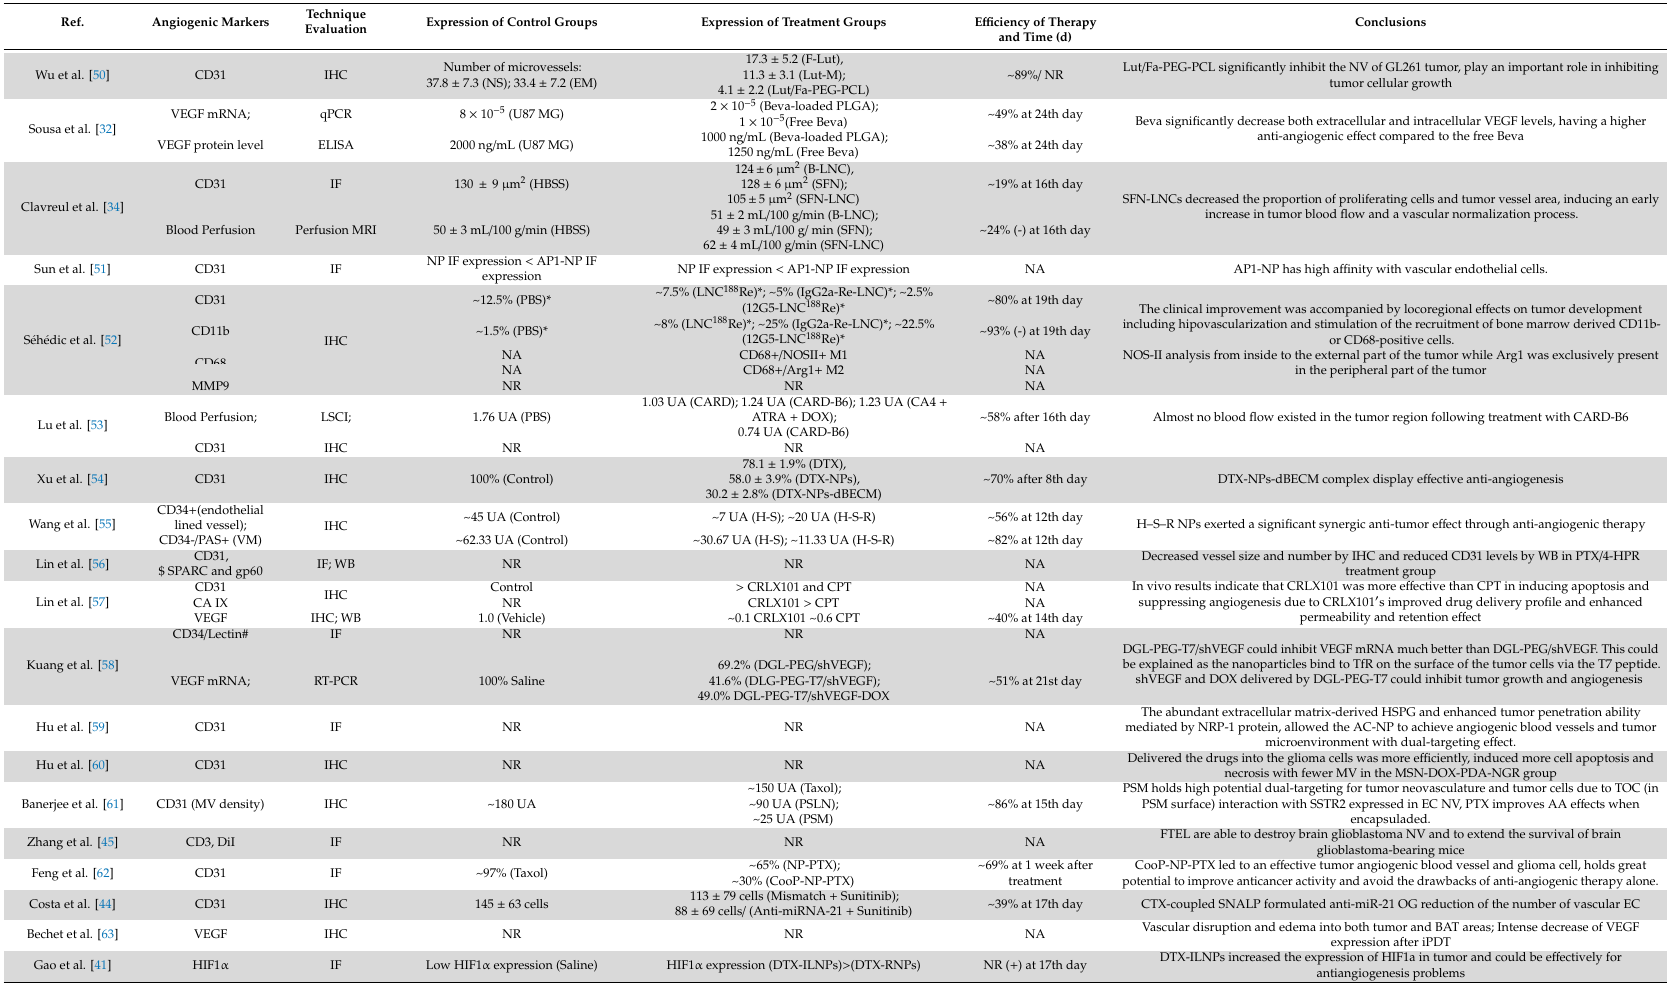
Table 5. Angiogenic e ff ects